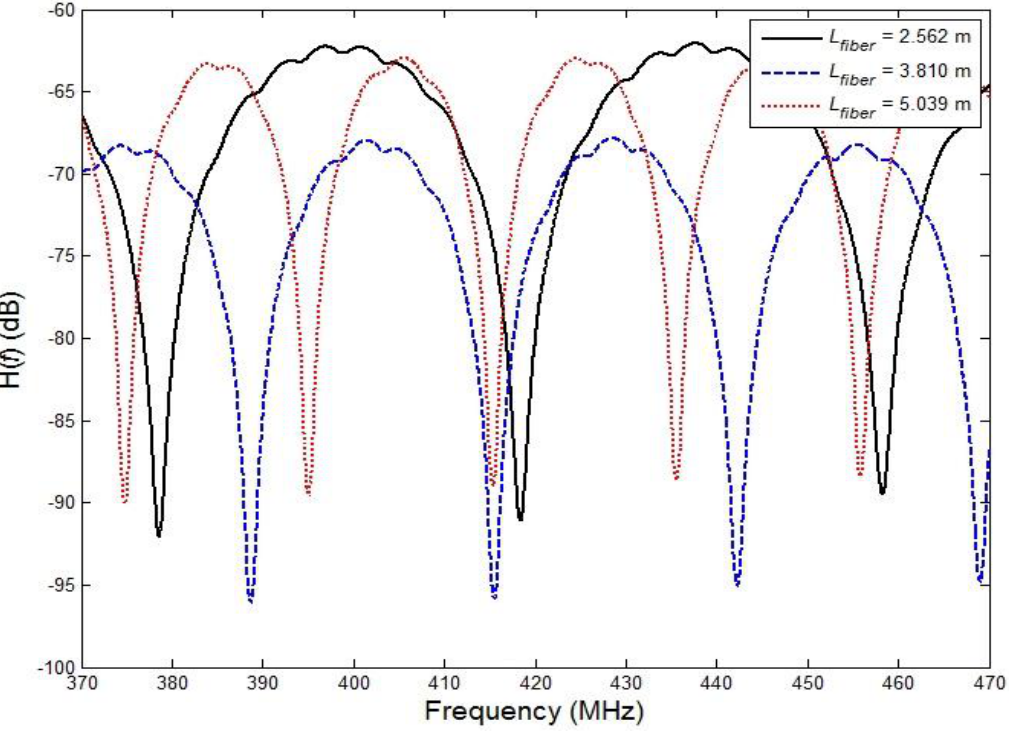
Figure 3. Measured transfer function H ( f ) for three different optical fiber lengths between an MZ-EOM and CFBG: = 2.562 m, = 3.810 m, and = 5.039